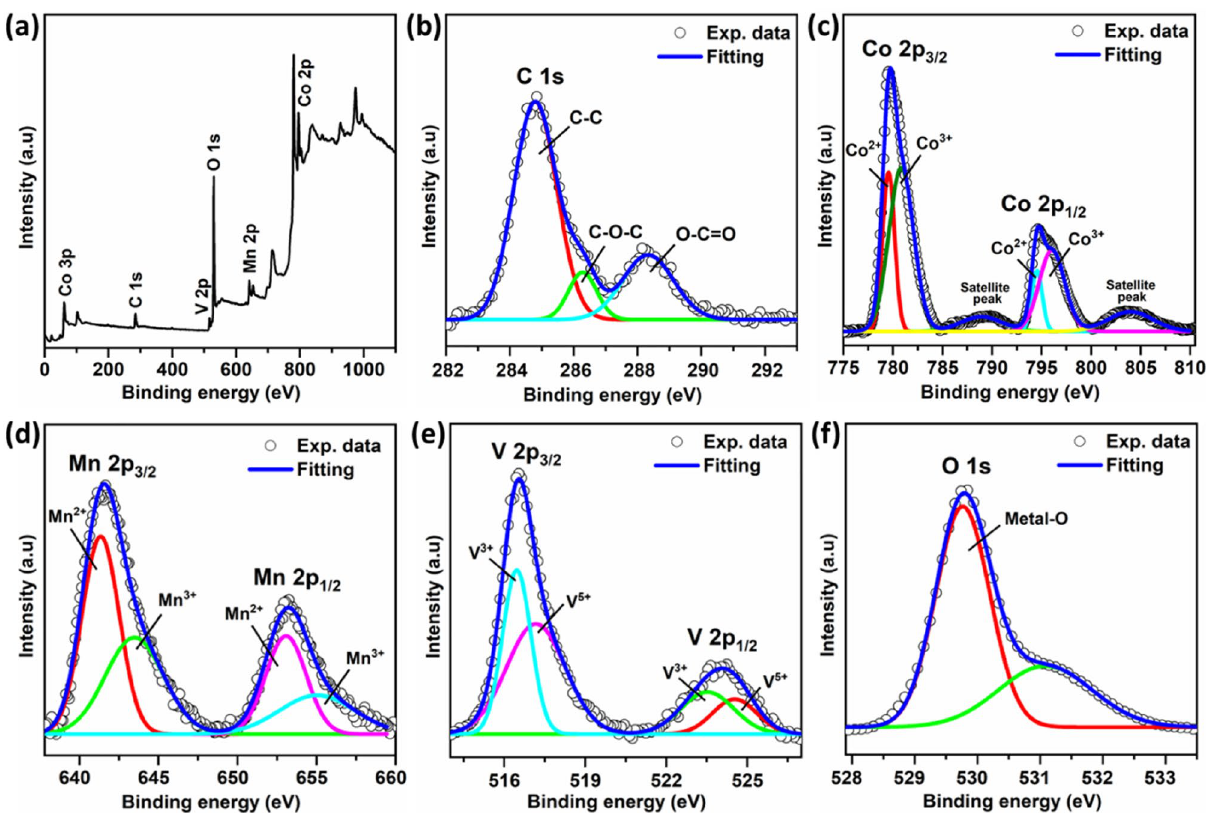
Figure 5. XPS analysis of V x -MnCo MCs (x = 0.3) sample represents (a) survey scan and core level spectrum of (b) C 1s, (c) Co 2p, (d) Mn 2p, (e) V 2p, (f) O 1s.